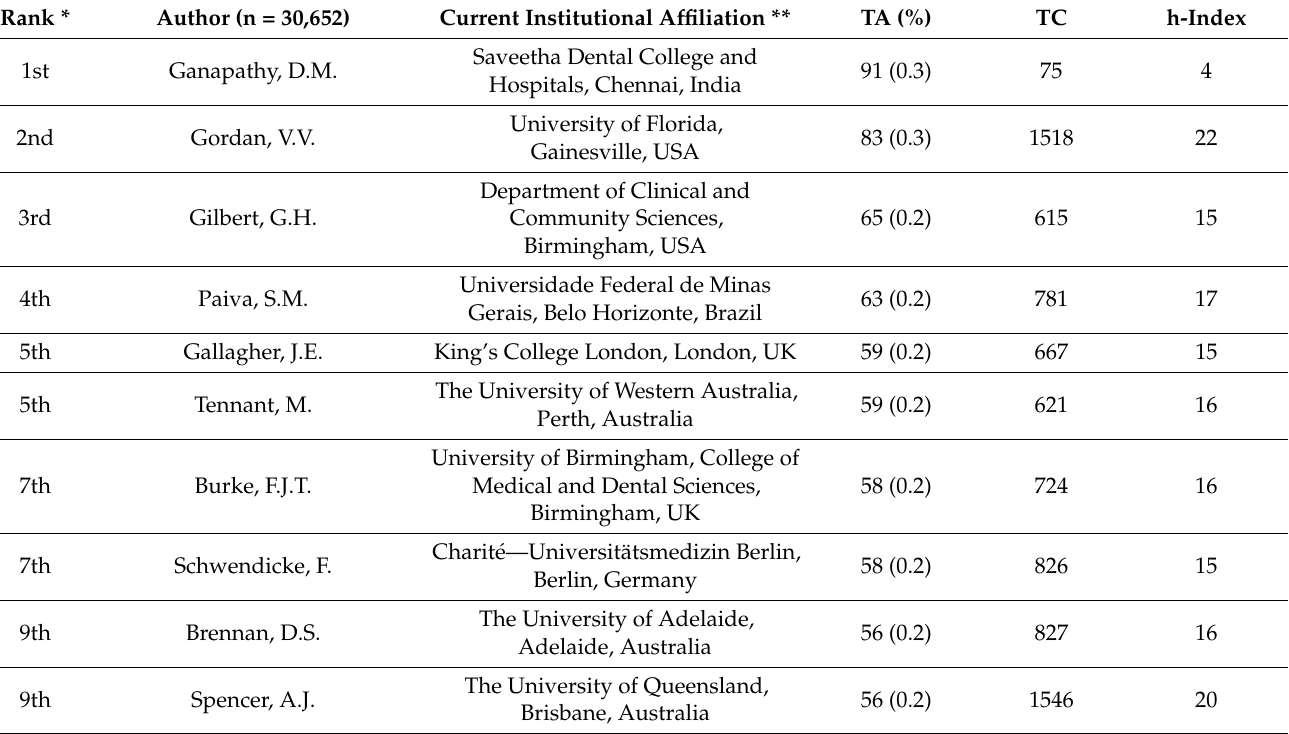
Table 8. Top ten authors of articles on